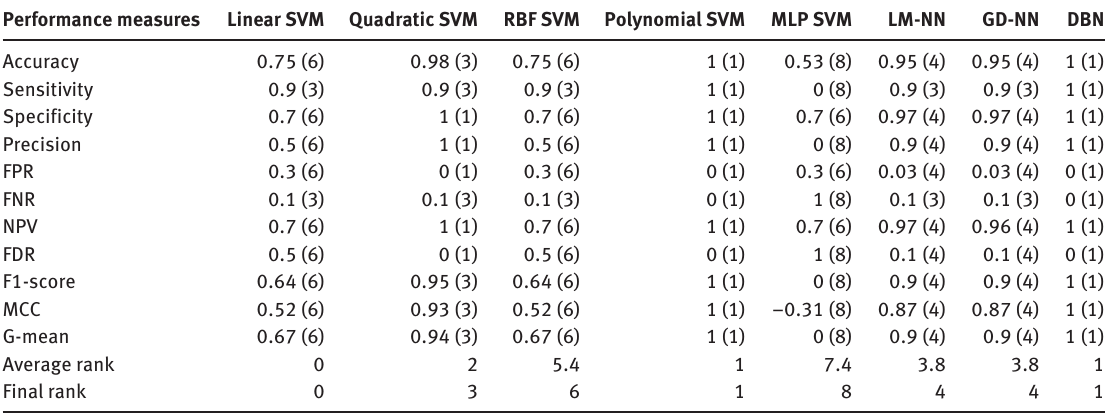
Table 4: Performance Analysis of Proposed and Conventional Fault Signal Recognition in Power Distribution System for Swell Signal. Performance measures